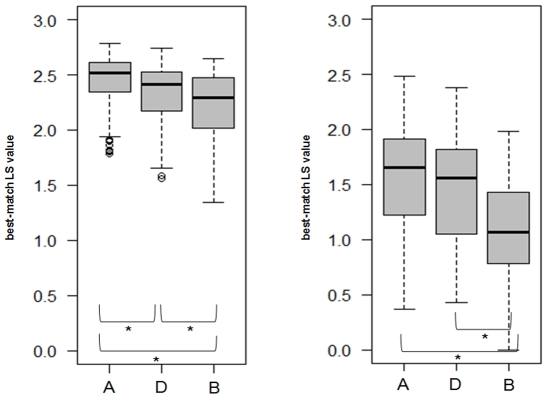
Comparison of the technical and biological reproducibility between the procedure A, B and D.(A) Box-and-whisker diagram of the best-match LS value obtained in the technical reproducibility test. (B) Box-and-whisker diagram of the best-match LS value obtained in the biological reproducibility test. The bottom and top of the box are the lower and upper quartiles, respectively; the dark band is the median; and the ends of the whiskers represent the lowest datum included in the 1.5 interquartile range (IQR) of the lower quartile and the highest datum included in the 1.5 IQR of the upper quartile). Asterisks indicate which pairs of procedures were statistically different (Wilcoxon tests, p<10−3). The pairwise matched Wilcoxon tests with Holm's adjustment for multiple comparisons indicated that the technical reproducibility was significantly better with procedure A than with procedures B and D (p<10−16 and p<10−12 respectively). Furthermore, the biological reproducibility with procedure B was significantly poorer than with procedure A (p<10−9).